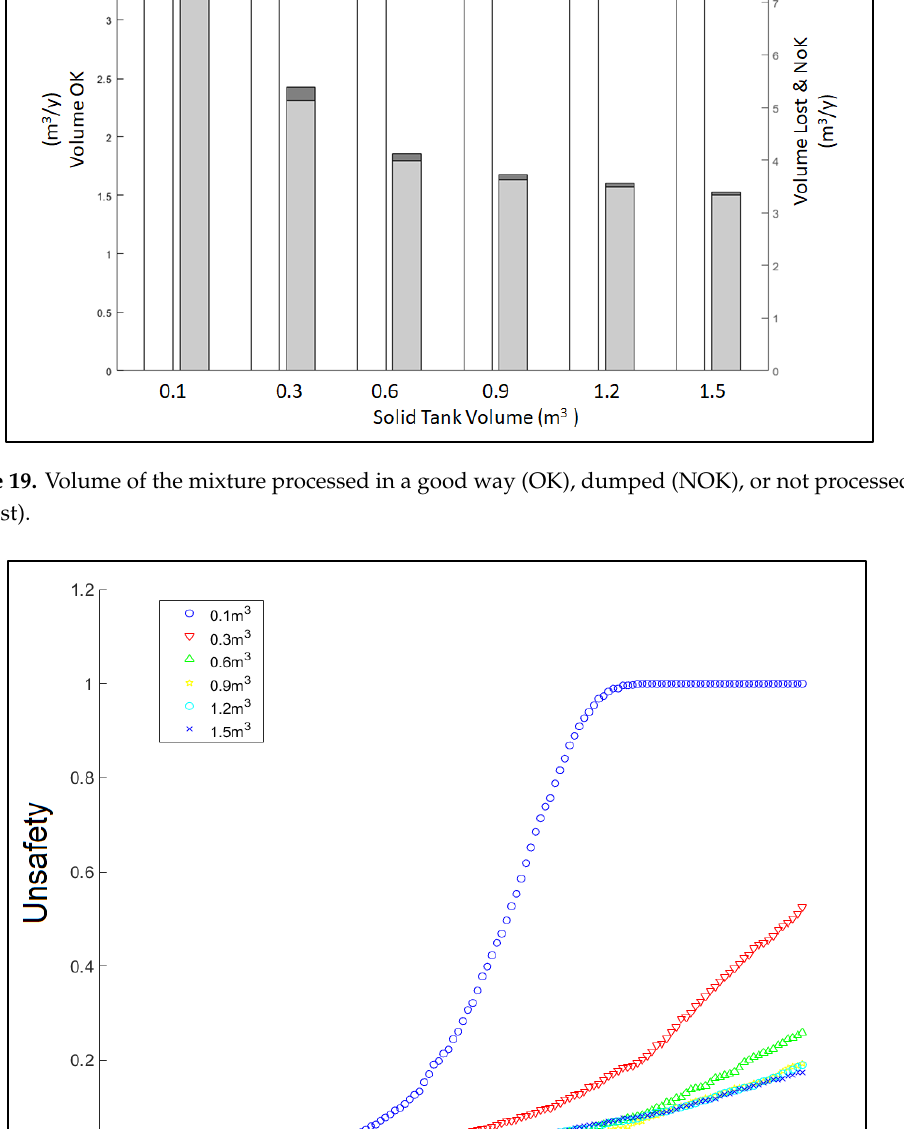
Figure 19. Volume of the mixture processed in a good way (OK), dumped (NOK), or not processed at all (Lost).